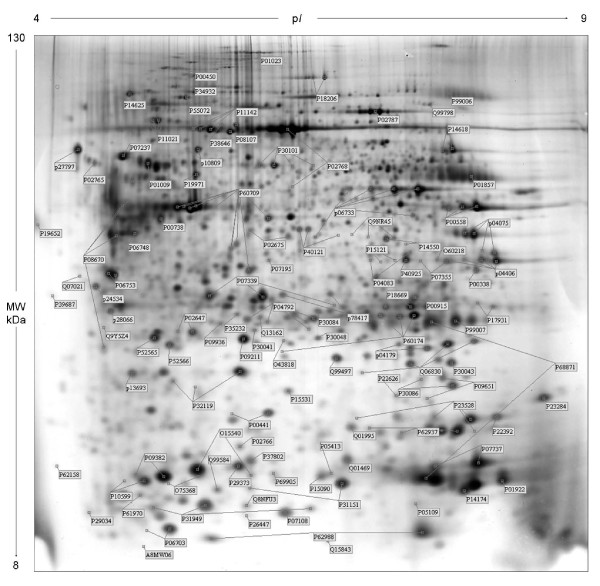
Representative gel image of a breast cancer tissue. 2-D separation was performed on IPG gel strips (18 cm, 3.0-10 NL) followed by the SDS-PAGE on a vertical linear-gradient slab gel (9-16%T). Protein spots of known identity are marked with the Swiss-prot accession number. When present, different isoforms of the same protein were jointly labelled.